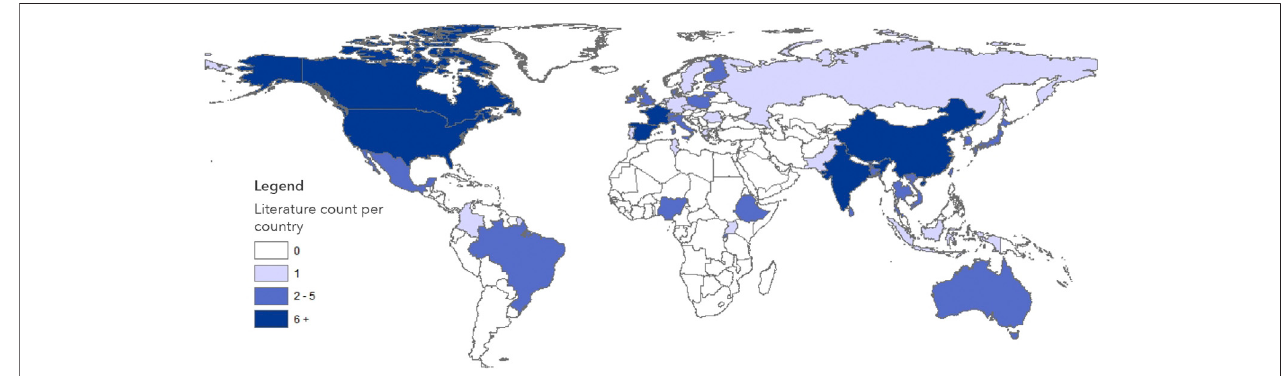
FIGURE 1 | Countries represented in the NBS review (129 out of 188 papers with country-speci fi c fi eld experiments, excluding literature reviews and laboratory experiments).